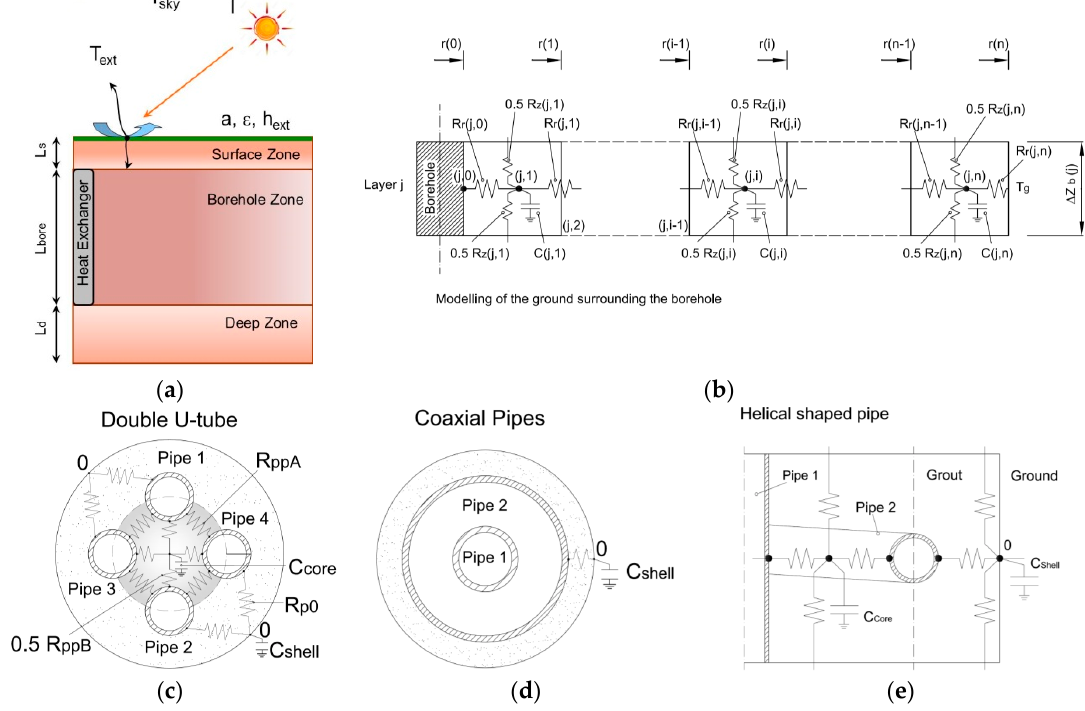
Figure 3. The CaRM modelling approach: ( a ) overview; ( b ) ground; ( c ) double U-tube; ( d ) coaxial pipes; ( e ) helical shaped pipe.